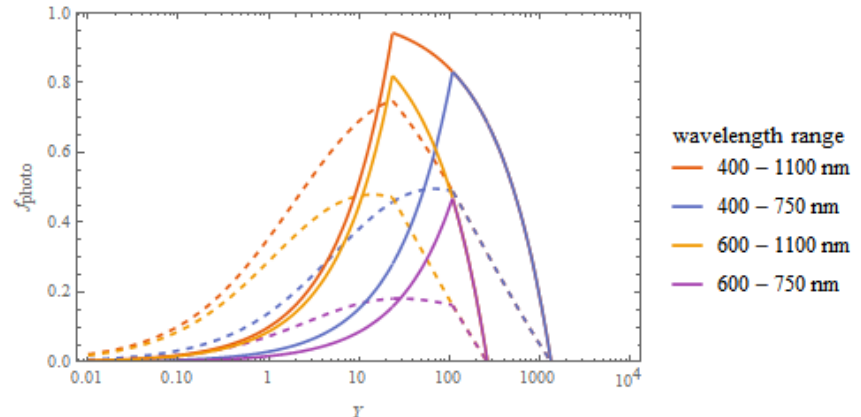
Figure 3. The fraction of stars which are capable of supporting photosynthesis as a function of the composite parameter Y defined in the text. The different curves correspond to taking the minimal wavelength to be both 400 nm and 600 nm, and the maximal to be 750 and 1100 nm. The solid curves use the estimate in Equation (8), and the dashed curves use the more refined initial mass function (IMF) of Equation (26).